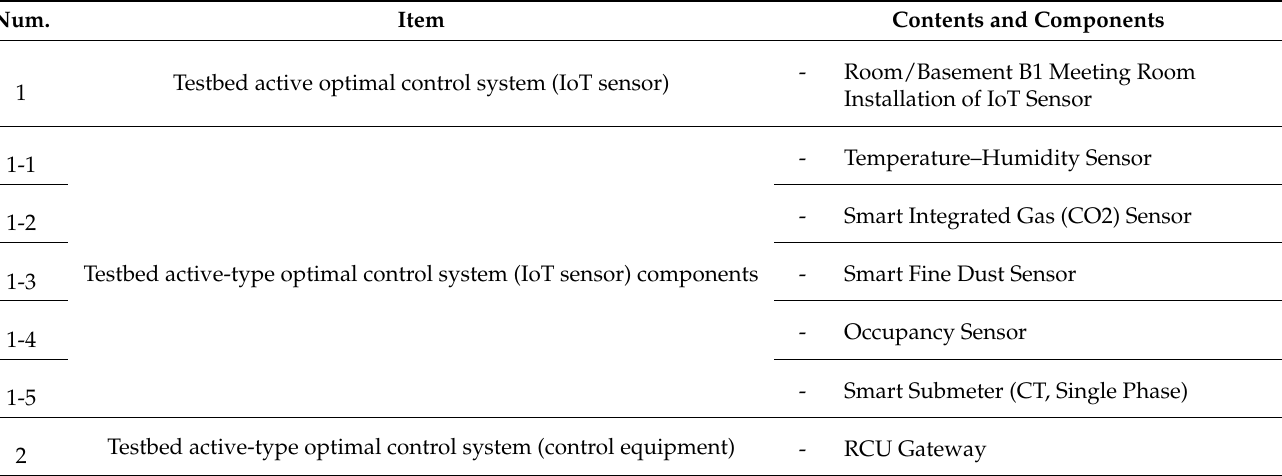
Table 3. Device and IoT Package Configuration in The